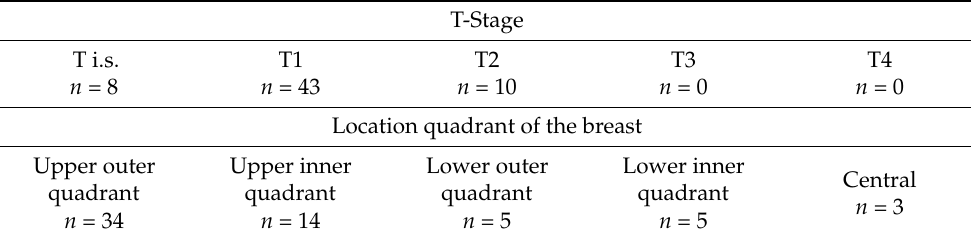
Table 1. Patients‘